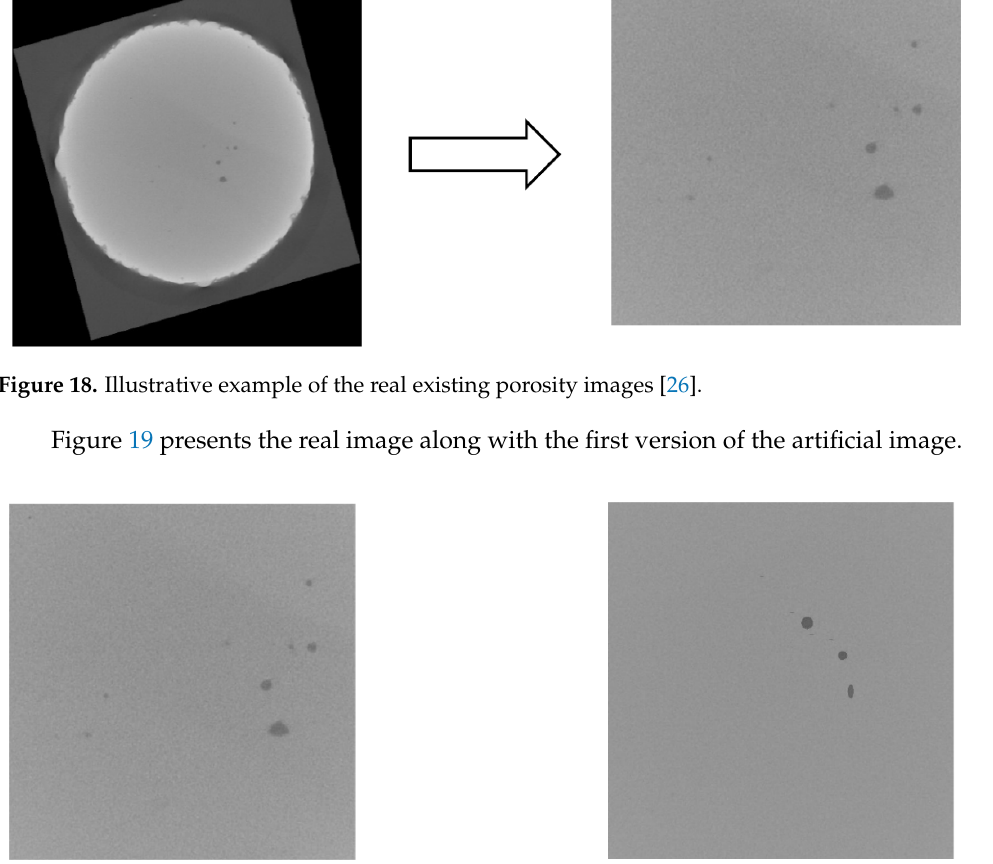
Figure 19. Real image ( Left ) vs. first version of artificial image ( Right ).